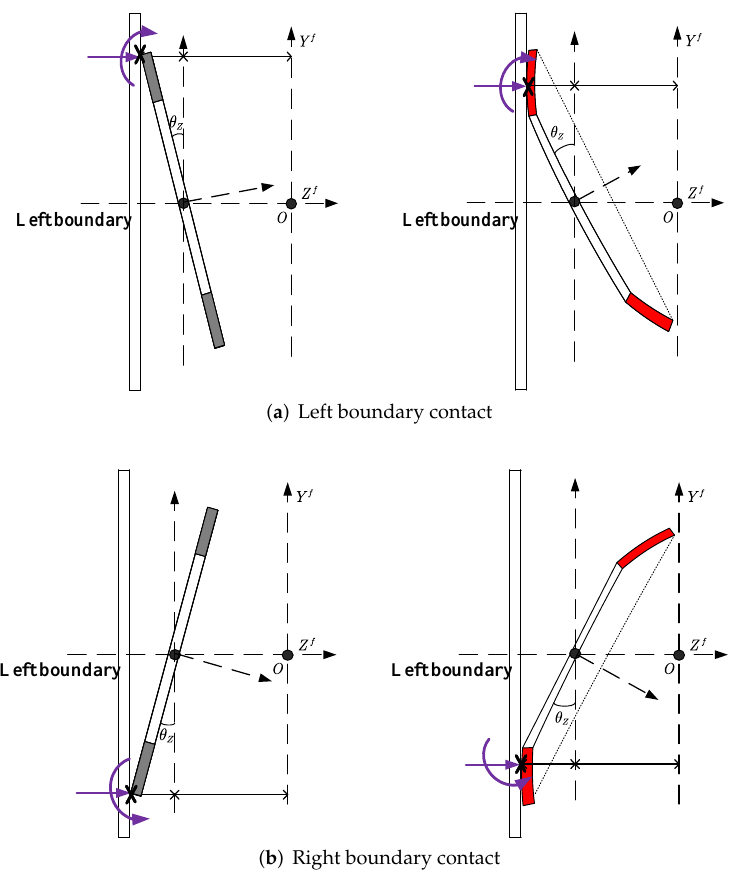
Figure 8. Left boundary impact of deformed